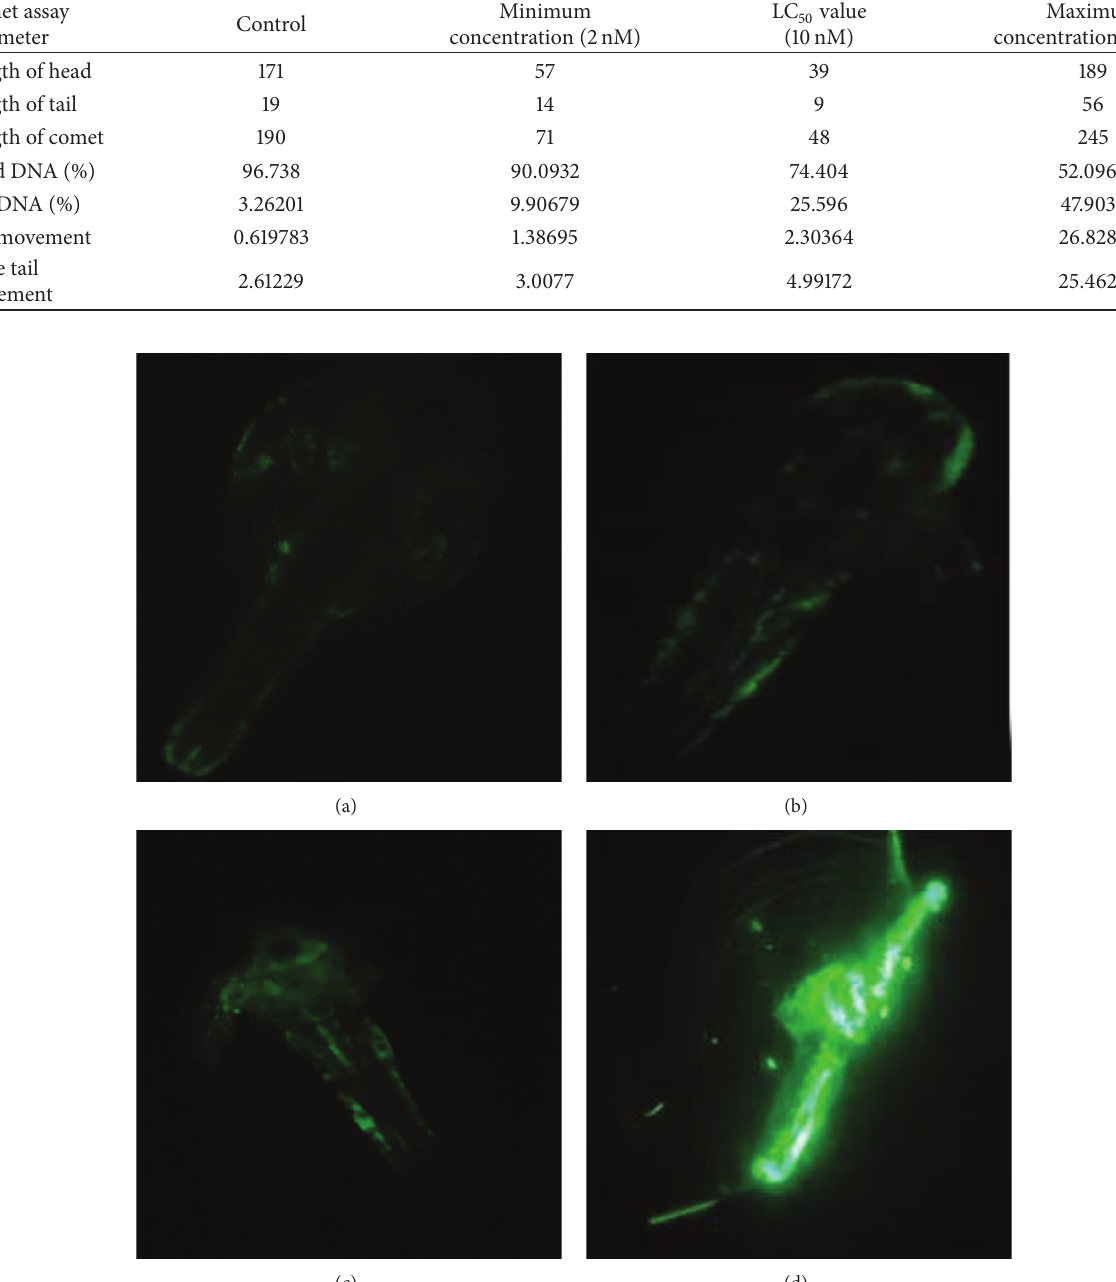
Figure 6: Acridine orange stained Artemia nauplii treated with silver nanoparticles observed using fluorescence microscope (20x magnification): control (a), 2 nM concentration of AgNPs (b), LC 50 concentration (10nM) of AgNPs (c), and 12nM concentration of AgNPs